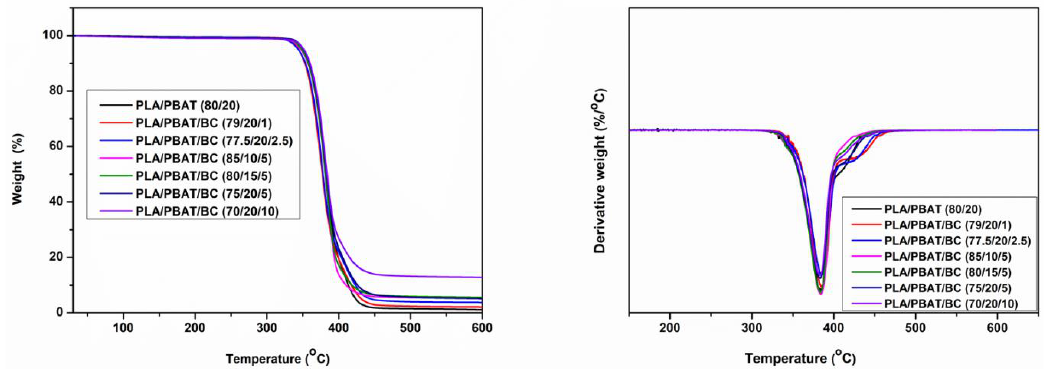
Figure 5. TGA analysis of biochar composites.